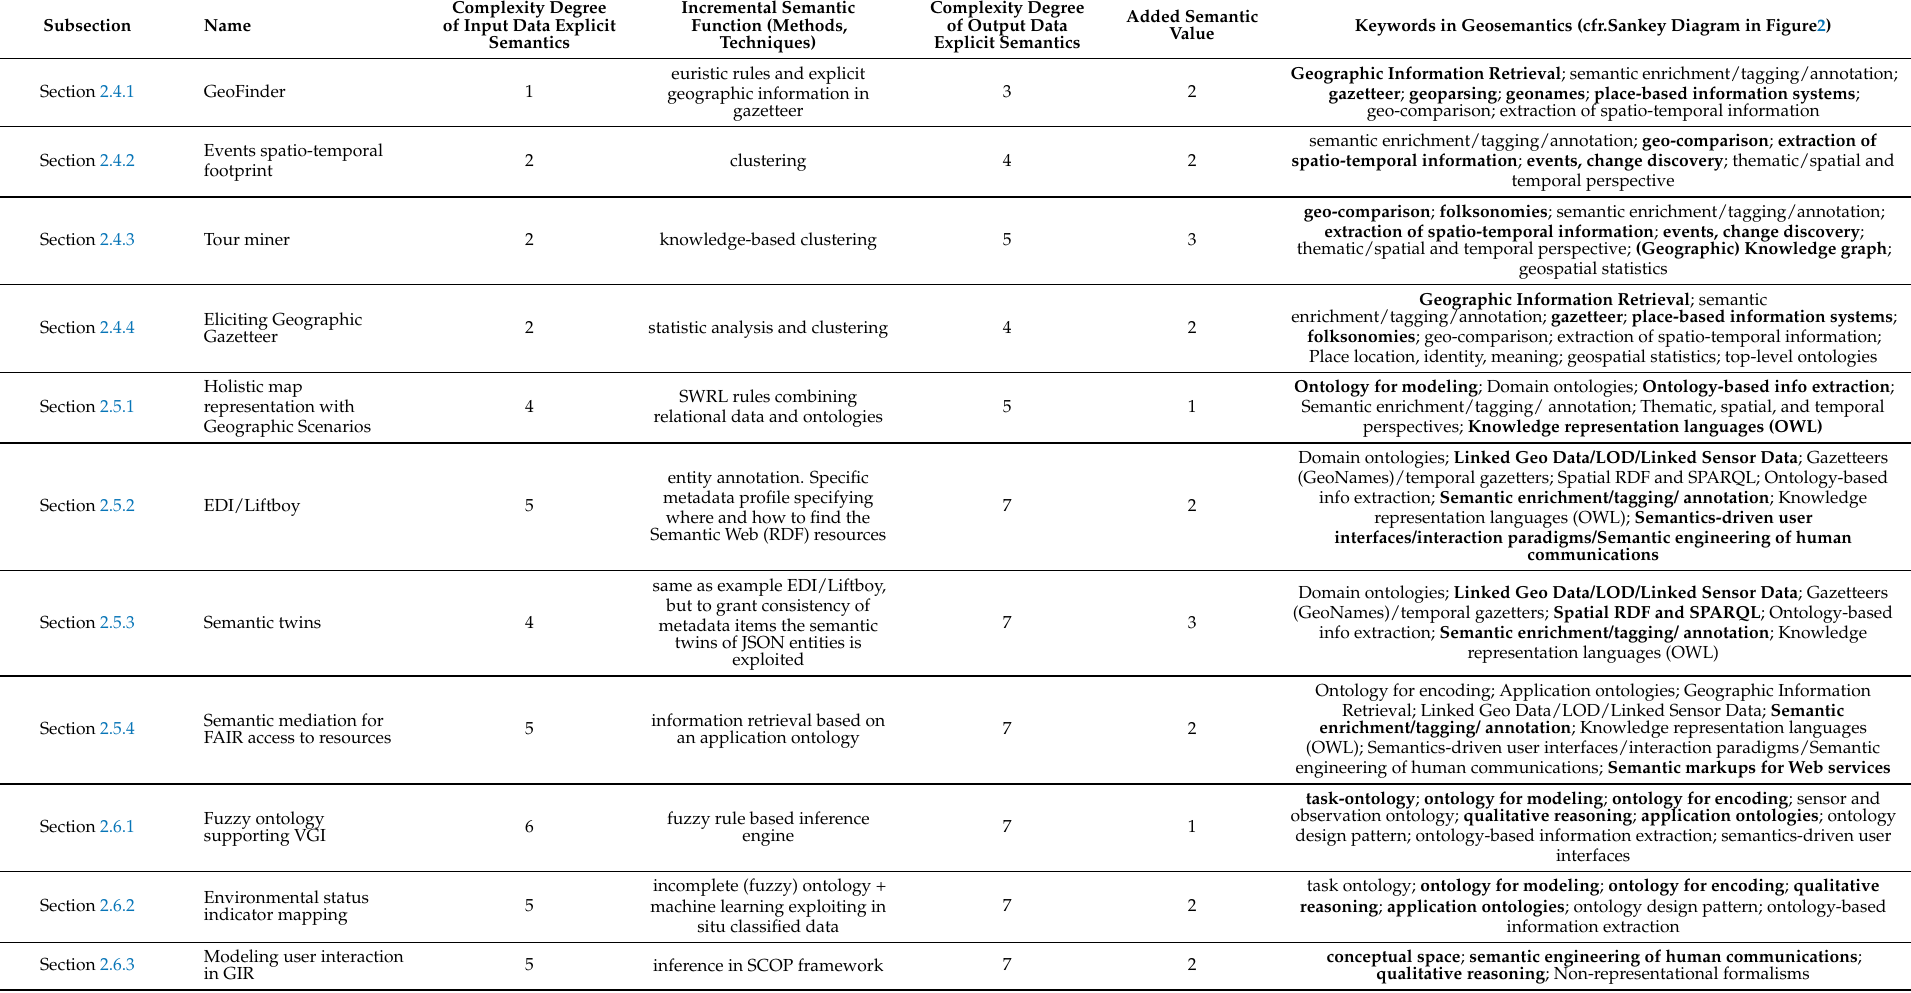
Table 4. Dimensions of case